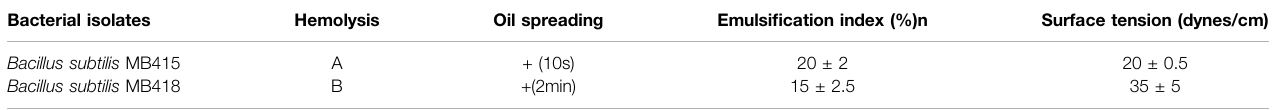
TABLE 1 | Results of biosurfactant screening assays. Bacterial